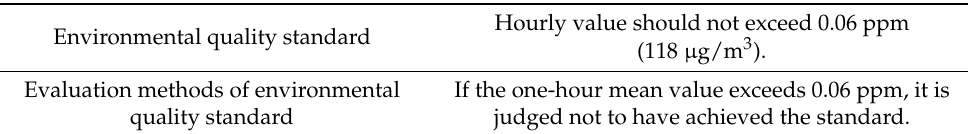
Hourly value should not exceed 0.06 ppm (118 µ g/m 3 ).